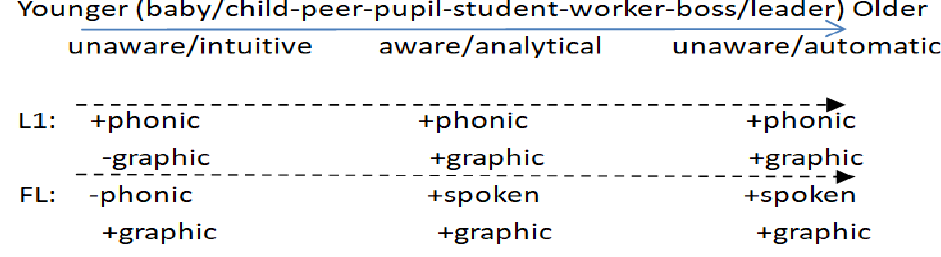
Figure 3. Different L1 and FL contextualized processes.